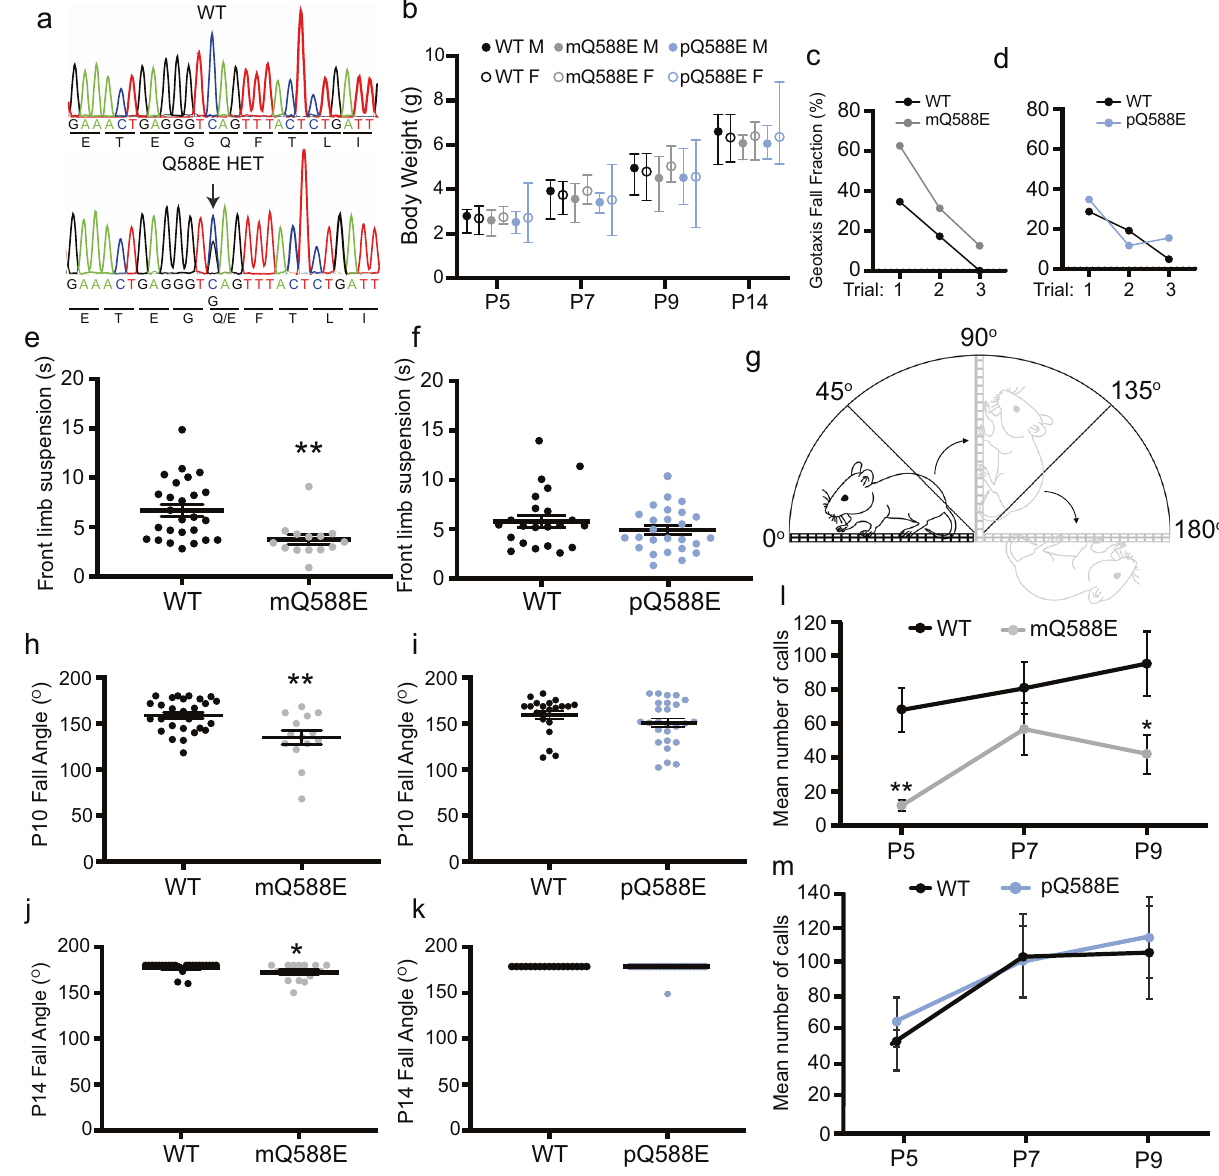
Fig. 6 UBE3A Q588E mutation perturbs neurological function in a mouse model. a The genomic region containing the coding sequence for position Q588 in UBE3A was ampli fi ed and sequenced from WT and mQ588E mice. The arrow marks the mutated nucleotide. b Mean ± range of body weights of WT and mutant mice at postnatal (P) day 5, 7, 10, and 14. Solid black: WT males (WT M), Open black: WT females (WT F), Solid gray: mQ588E males (mQ588E M), Open gray: mQ588E females (mQ588E F), Solid blue: pQ588E males (pQ588E M), Open blue: pQ588E females (pQ588E F). The following numbers of animals were used for each group: WT M: P5, n = 13; P7, n = 13; P9, n = 10; P14, n = 11. WT F: P5, n = 10; P7, n = 10; P9, n = 9; P14, n = 6. mQ588E M: P5, n = 7; P7, n = 7; P9, n = 6; P14, n = 5. mQ588E F: P5, n = 9; P7, n = 9; P9, n = 8; P14, n = 5. pQ588E M: P5, n = 12; P7, n = 9; P9, n = 11; P14, n = 8. pQ588E